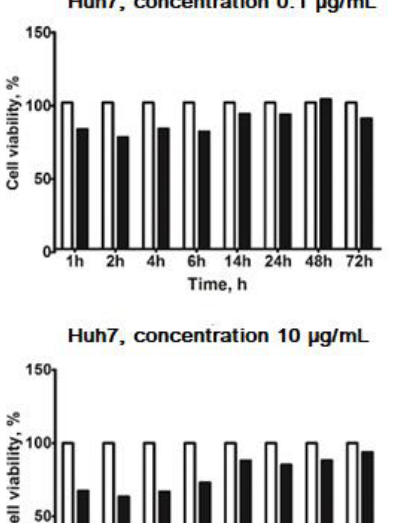
Figure 5. Temperature kinetics of a Fe 3 O 4 -Au NPs suspension in toluene (8.0 mg/mL) acquired applying for 300 s an alternating magnetic field of 17 kA/m amplitude (H 0 ) and 183 kHz frequency (f).